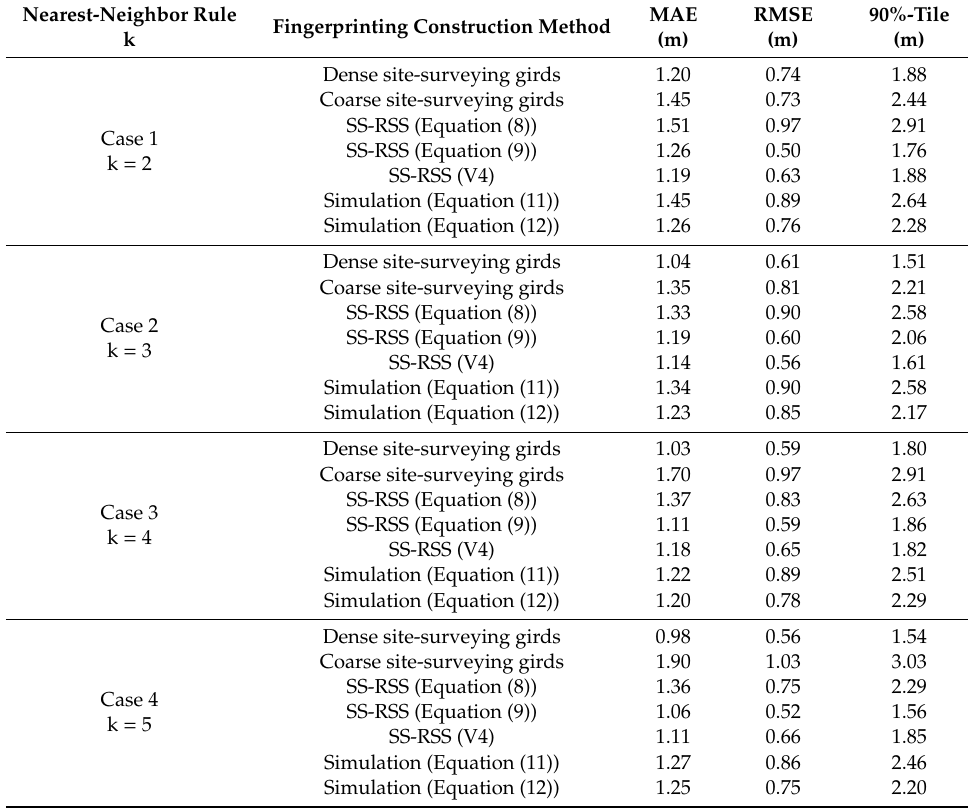
Table 3. Positioning results of di ff erent fingerprint construction methods based on k-nearest neighbor (KNN) versus the number of nearest